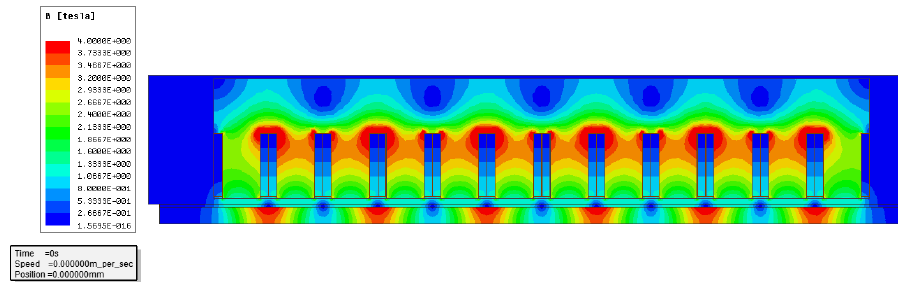
Figure 5. Distribution field diagram of static magnetic density.